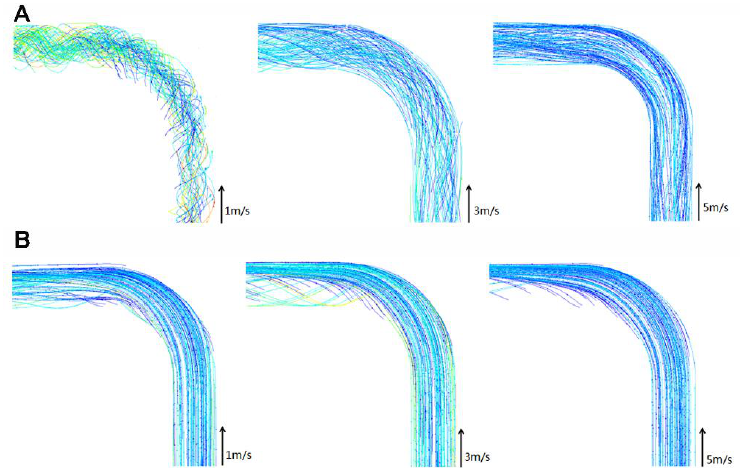
Figure 7. The trajectory of particles at the elbow: ( A ) represents static state and ( B ) represents vibration.